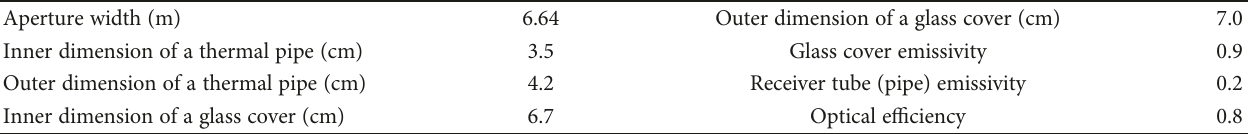
Table 1: The main geometrical and optical parameters of a collector.